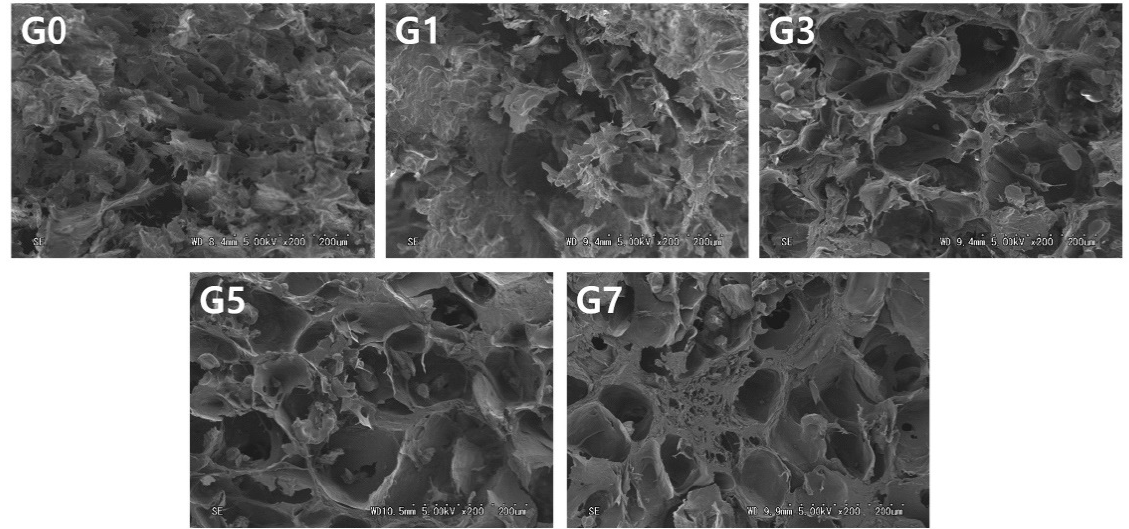
Figure 5. Scanning electron microscope images of abalone 3D print ink according to gelatin concen- tration (G0, 0%; G1, 1%; G3, 3%; G5, 5%; G7, 7%).